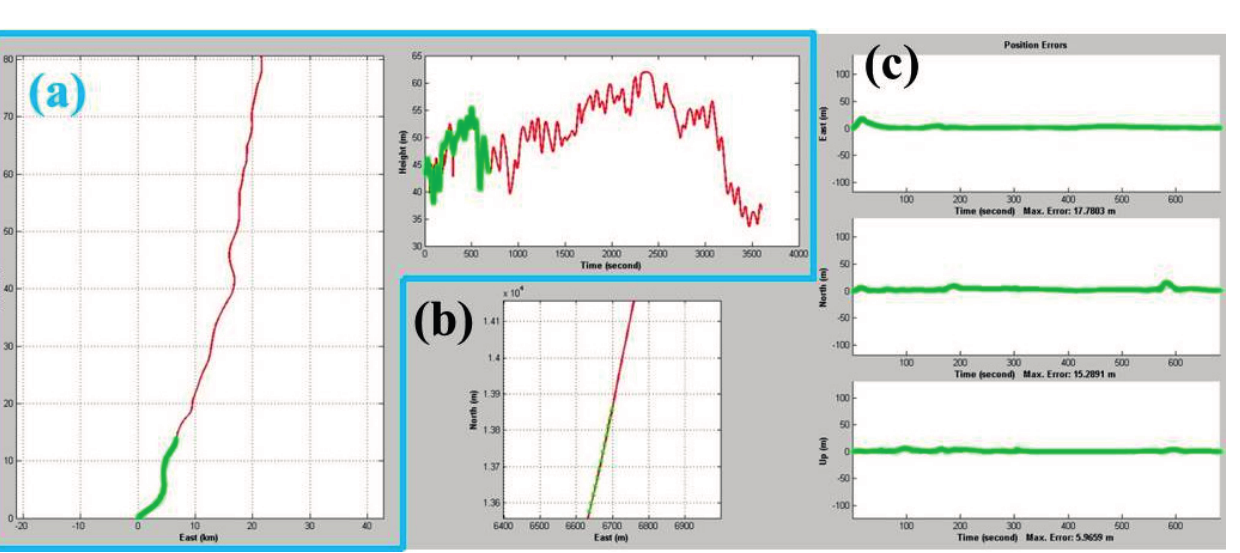
Figure 7. The interface of real-time display. ( a ) Overall position in east, north and height component; ( b ) Detailed position in horizontal component; ( c ) Error plots and maximum error of position compared to reference